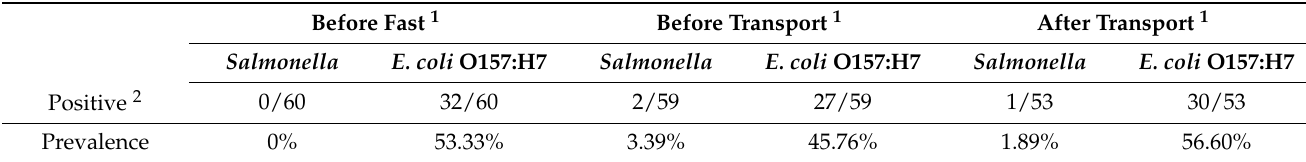
Table 1. Prevalence of Salmonella and E. coli O157:H7 of market pigs.